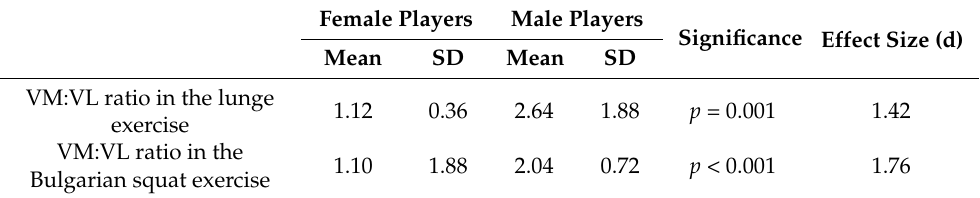
Table 2. VM:VL ratio (mean ±